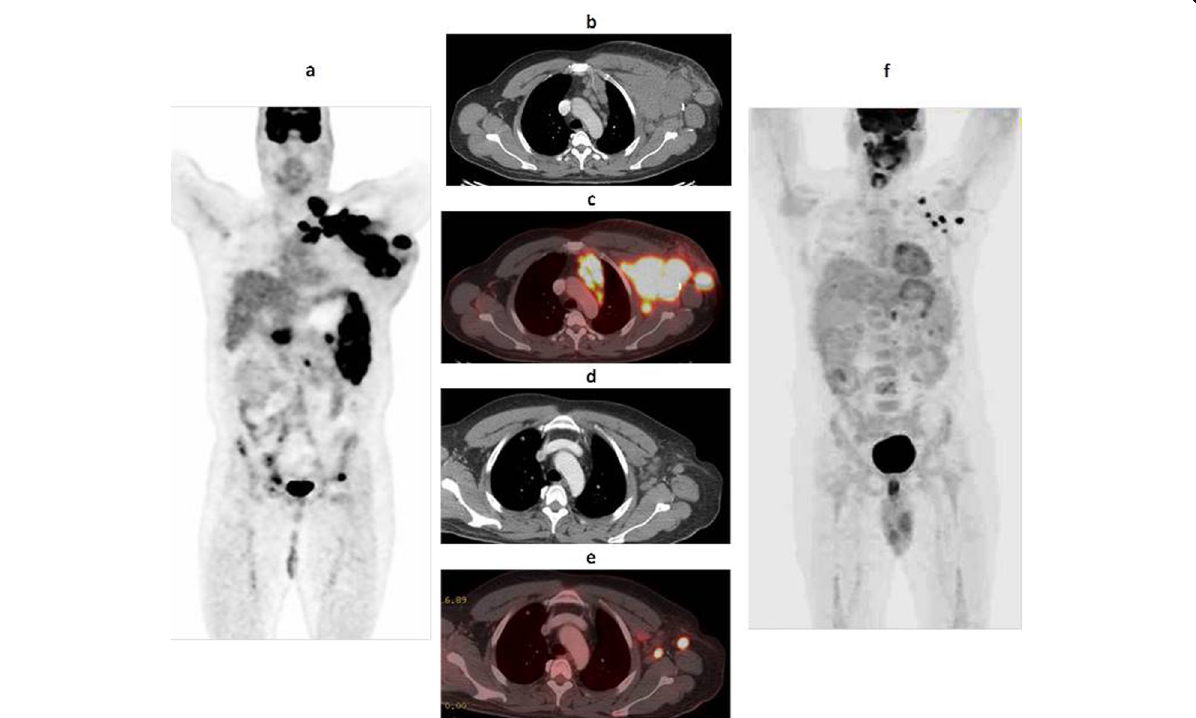
Fig. 2 A 43-year-old male patient, recently diagnosed case of T-cell NHL. Initial PET/CT study revealed hypermetabolic nodal and splenic lesions in whole body PET MIP image ( a ), the largest and most active lesions are seen at left axillary group as in axial CECT image ( b ), achieving up to 20 SUL peak in corresponding fused PET/CT image ( c ). Follow-up PET/CT study showed residual active lesions in whole body PET MIP image ( f ). The left axillary nodal lesions showed size regression in axial CECT image ( d ) denoting PR according to RECIST 1.1, yet with almost stationary FDG uptake (21 SUL peak ) in fused PET/CT image ( e ) denoting SMR according to PERCIST